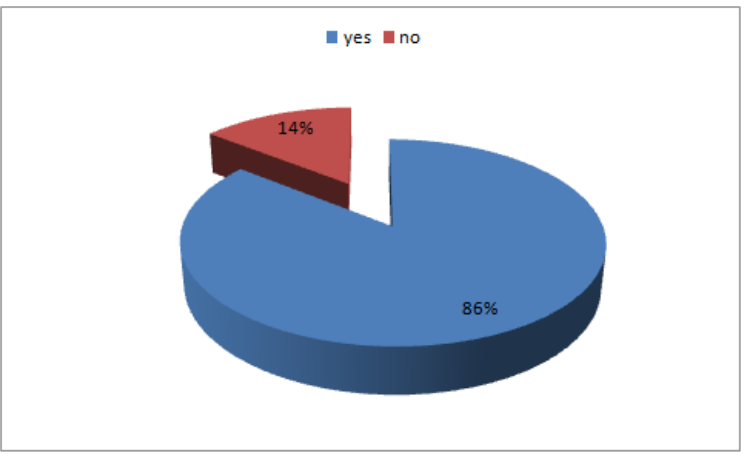
Figure 4: Enabling Personalized Banking Offers